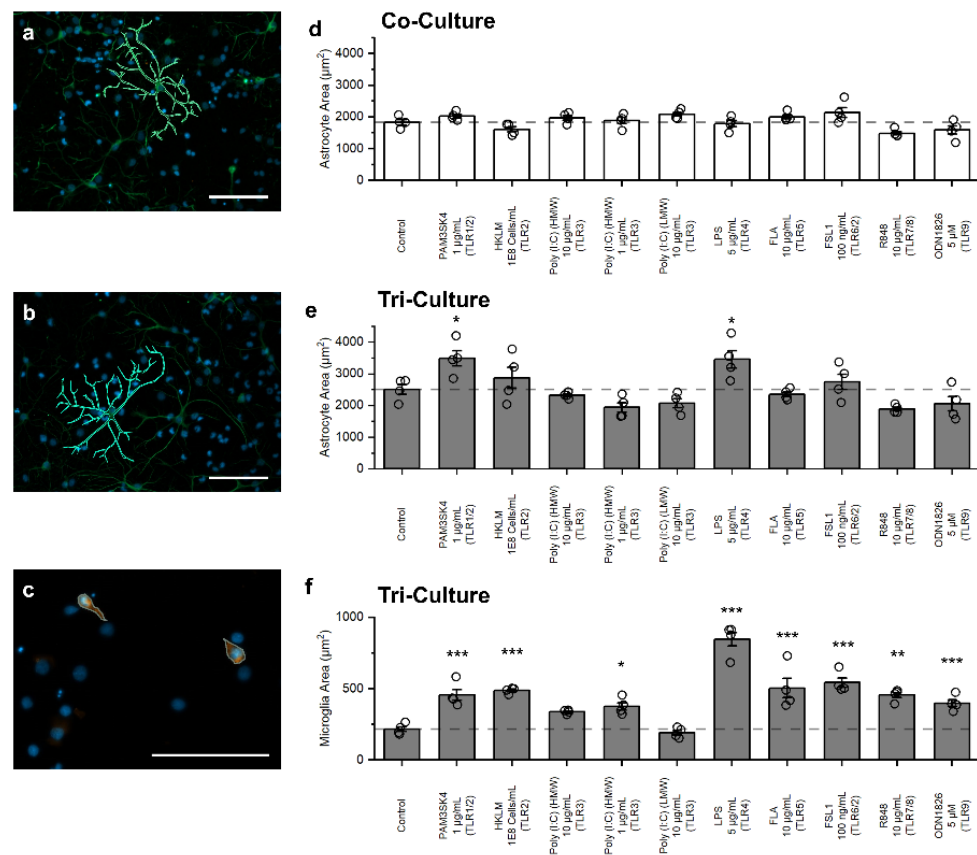
Figure 4. Influence on TLR agonist treatment on glial cell morphology. Representative fluorescence images of astrocytes in the ( a ) co-culture and ( b ) tri-culture, and ( c ) microglia in the tri-culture at DIV 9 showing the outlining method used to quantify area. Quantification of the average astrocyte area in ( d ) co-cultures and ( e ) tri-cultures following 48 h exposure to TLR agonists. ( f ) Quantification of the average microglia area in the tri-cultures following 48 h exposure to TLR agonists. Data presented as mean ± SEM (n = 4 wells from two independent dissections) with individual data points plotted, * p < 0.05, ** p < 0.01, *** p < 0.001 (as determined by a one-way ANOVA followed by Dunnett’s test vs . vehicle control). Scale bar = 100 µm.